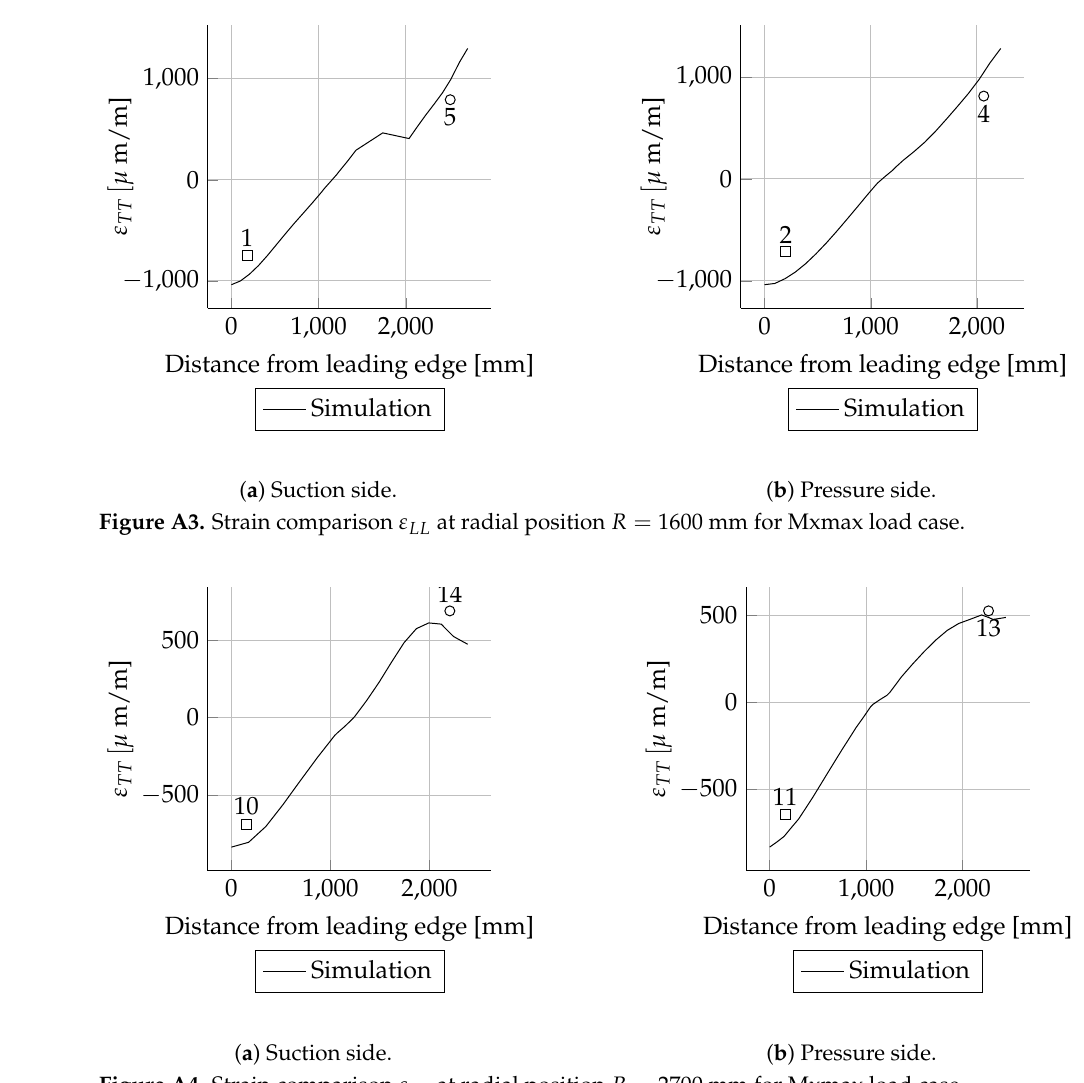
Figure A4. Strain comparison ε LL at radial position R = 2700 mm for Mxmax load case.